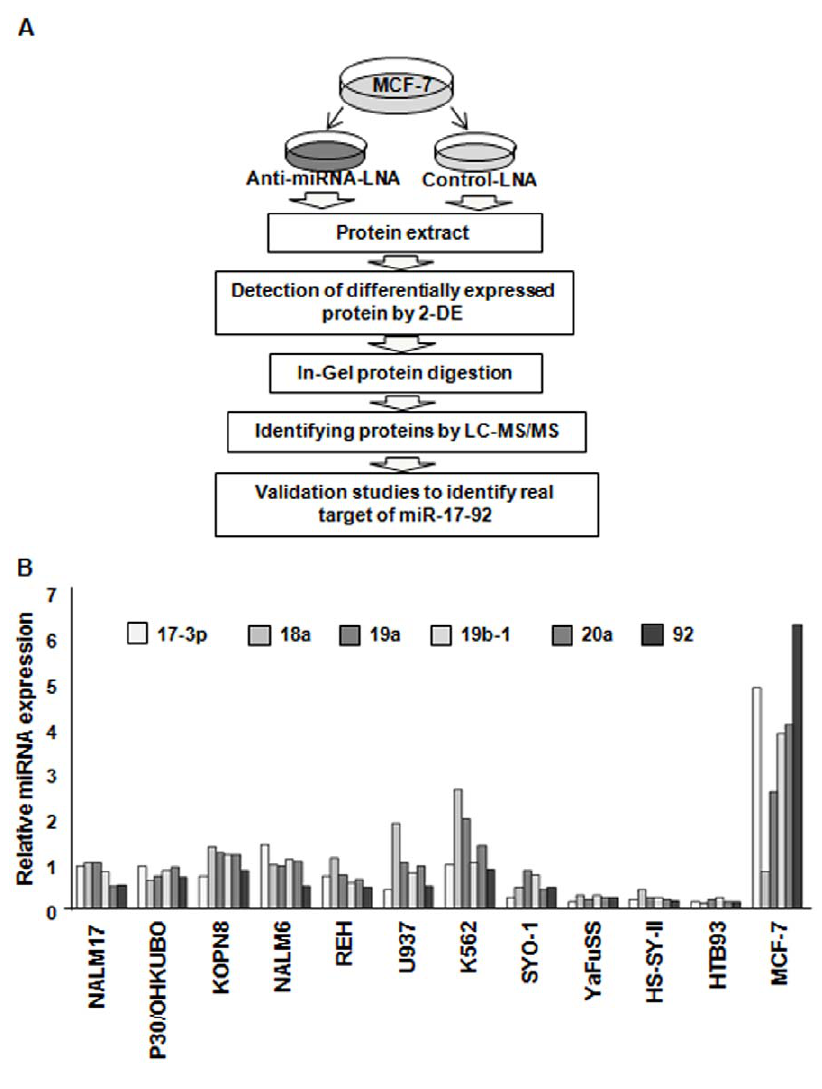
Figure 1. The strategy for identifying miR-17-92 targets. (A) The workflow for the identification of target proteins. MCF-7 cells were transfected with an anti-miRNA-LNA or control-LNA. Proteins were extracted 72 hours after transfection, and subjected to two-dimensional gel electrophoresis to detect differentially expressed proteins. Significantly overexpressed spots/proteins were digested with trypsin and identified by LC-MS/MS. (B) The expression of miR-17-92 in 12 human cancer cell lines. The expression level of each miRNA was normalized to that of an internal control, U6B RNA, in the same cell line, and was presented in comparison to the averaged value of the 12 cell lines for each miRNA.